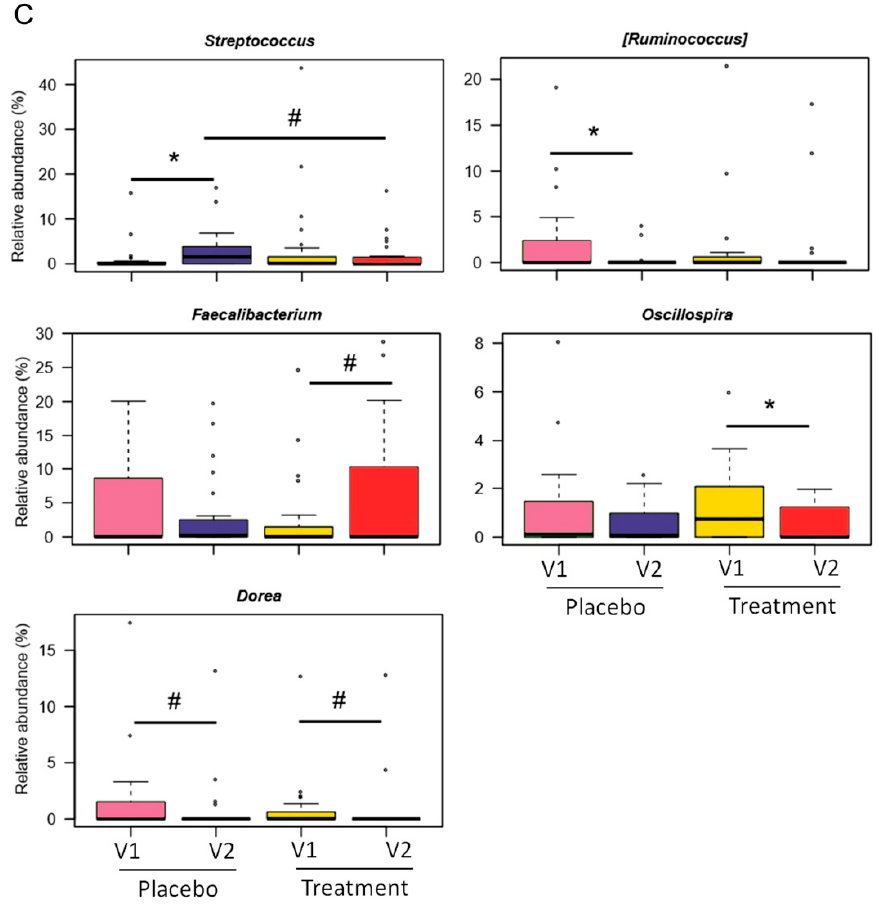
Figure 2. Gut microbiome profile of IBS patients after treatment with geraniol (LAGS) or placebo. ( A ) Boxplots showing the distribution of alpha diversity as measured by Faith’s PD (left) and number of observed ASVs (right) in IBS patients before (V1) and after (V2) 4 weeks of treatment with geraniol or placebo. Boxplots showing the relative abundance distribution of families ( B ) and genera ( C ) differentially represented between groups are reported. Wilcoxon signed-rank test, * for p < 0.05, # for p < 0.1.